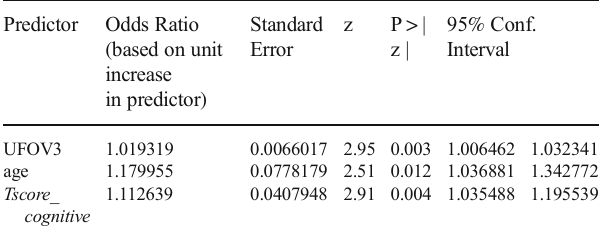
Standard z P > | 95% Conf. Error z |